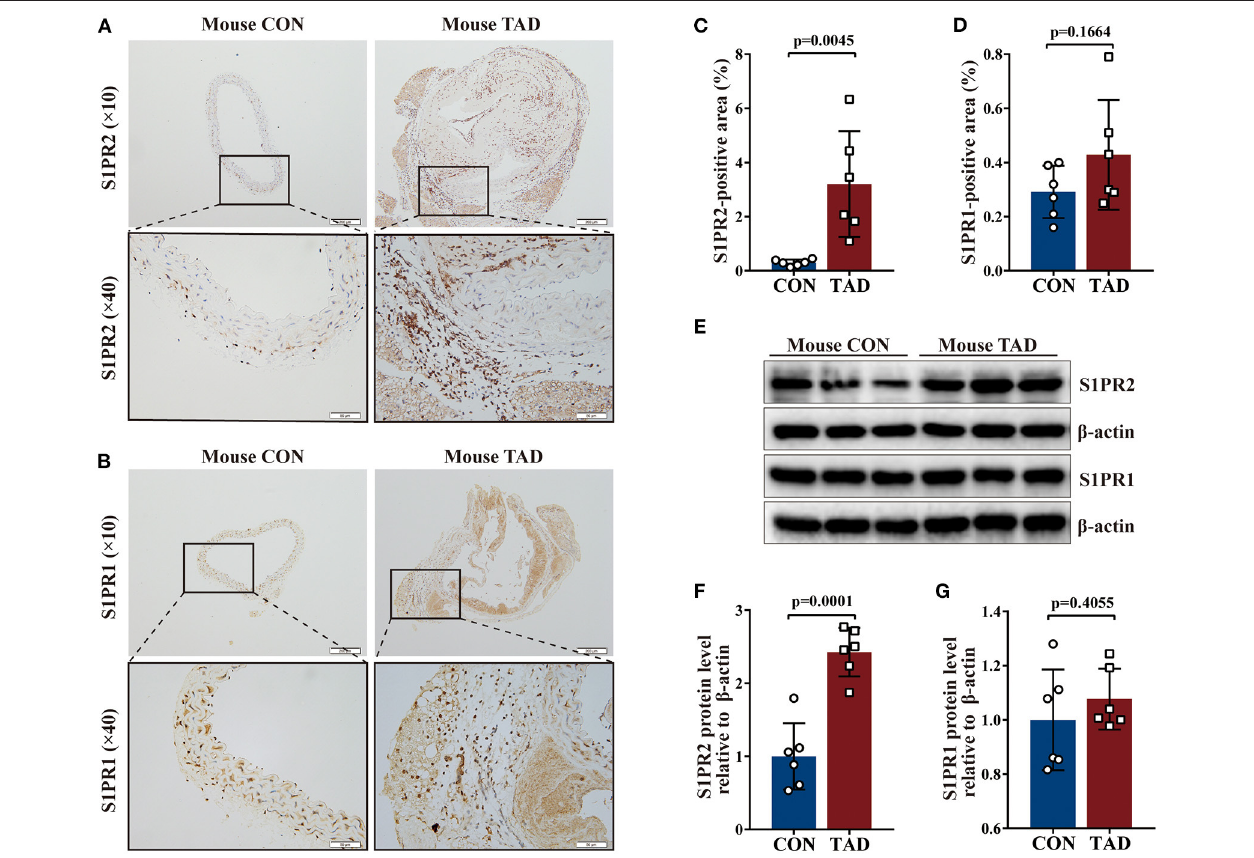
FIGURE 2 | Increased S1PR2 accumulation in mouse TAD lesions. Representative immunohistochemistry images and the corresponding analysis of mouse S1PR2 (A,C) and S1PR1 (B,D) in TAD lesions ( n = 6) and control thoracic aorta ( n = 6). Representative immunoblot and the corresponding analysis of mouse S1PR2 (E,F) and S1PR1 (E,G) in TAD lesions ( n = 6) and control thoracic aorta ( n = 6). Scale: 200 µ m, inset: 50 µ m. Data are expressed as means ±